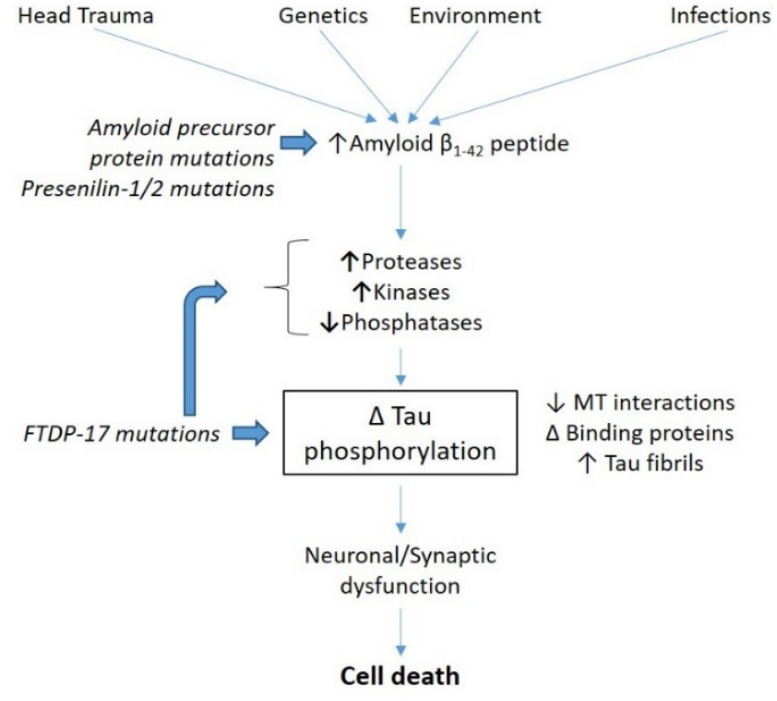
Figure 1. Diagram illustrating events that can contribute to neuronal dysfunction in AD and/or frontotemporal dementia and parkinsonism related to tauopathies of tauopathies of tauopathies of chromosome 17 (FTDP-17), and the crucial role played by alterations in tau protein phosphorylation. Reproduced with permission from [32]; published by Elsevier, 2005.